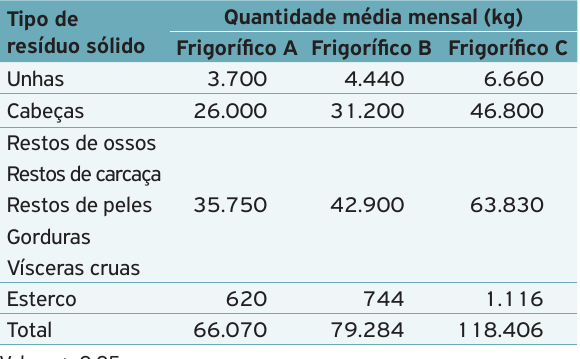
Tabela 1. Tipo e quantidade de resíduos sólidos gerados em frigoríficos que abatem bovinos na cidade de São Luís, Maranhão,